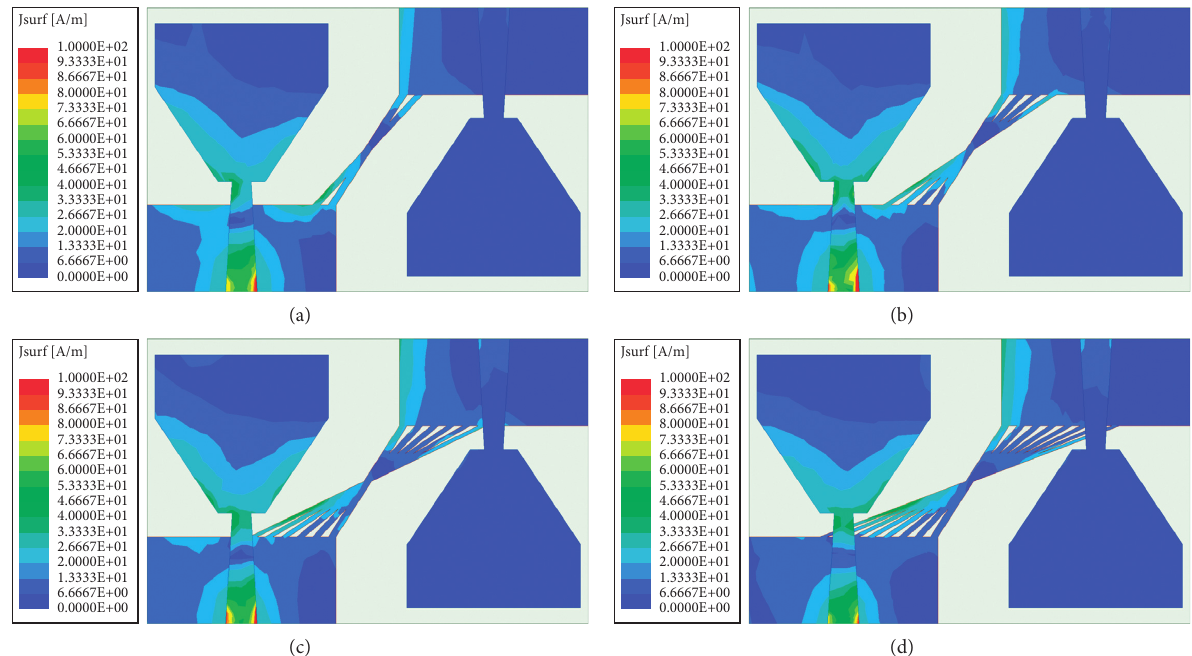
Figure 10: Surface current distribution of two-port antenna with different numbers of X-shaped stubs at 9GHz. (a) Num � 1. (b) Num � 2. (c) Num � 3. (d) Num � 4.